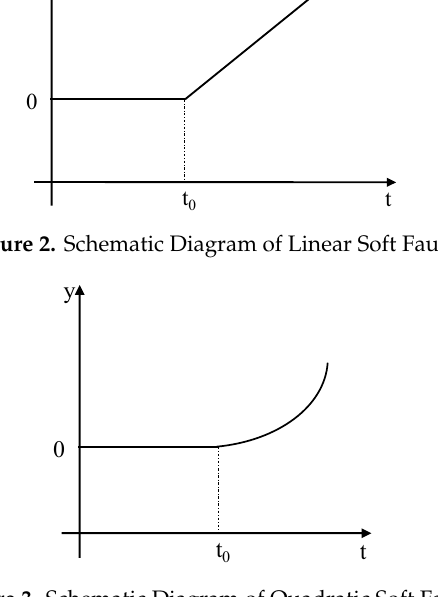
Figure 3. Schematic Diagram of Quadratic Soft Fault.